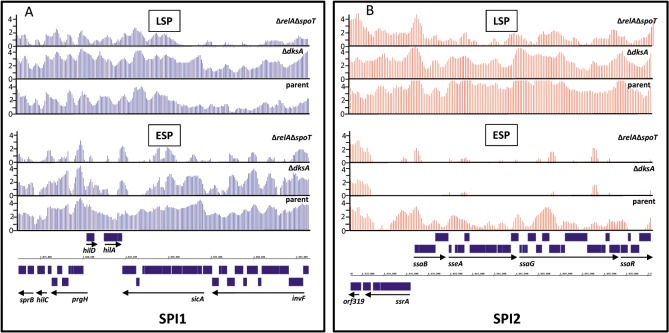
ChIP-chip profiles of RNAP distribution at the (A) SPI1 and (B) SPI2 loci in parental and ΔdksA and ΔrelAΔspoT strains at ESP and LSP viewed on the integrated genome browser (IGB) [65].Resolution of each peak is 100 nt.